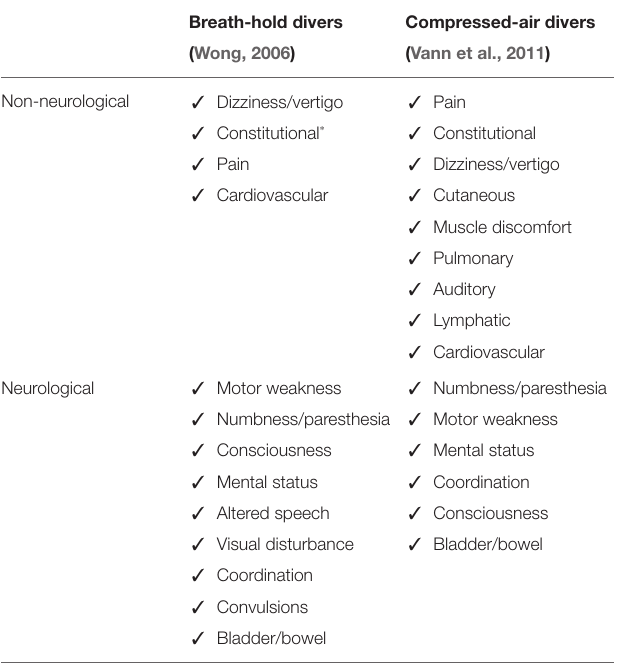
TABLE 1 | Clinical manifestations of decompression illness (DCI) in compressed- air and breath-hold (BH) divers. Breath-hold